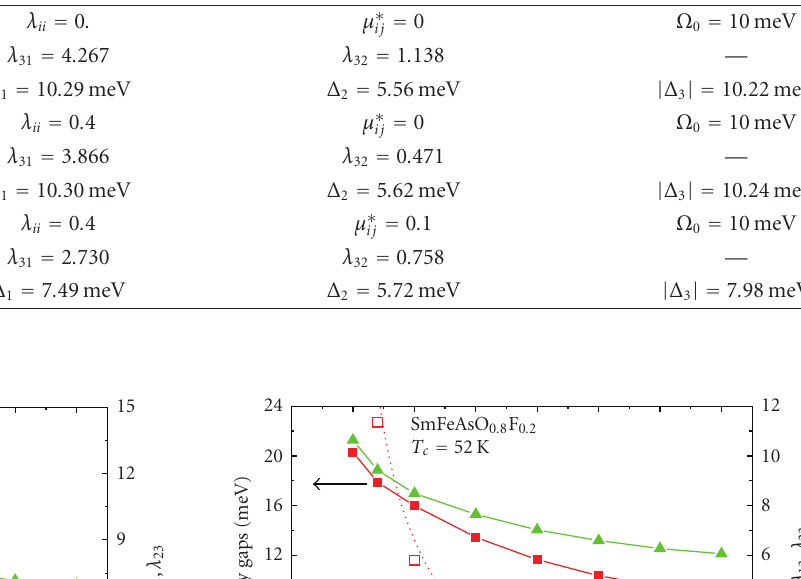
Table 1: The e ff ect of the intraband terms and Coulomb interaction on the gap values.